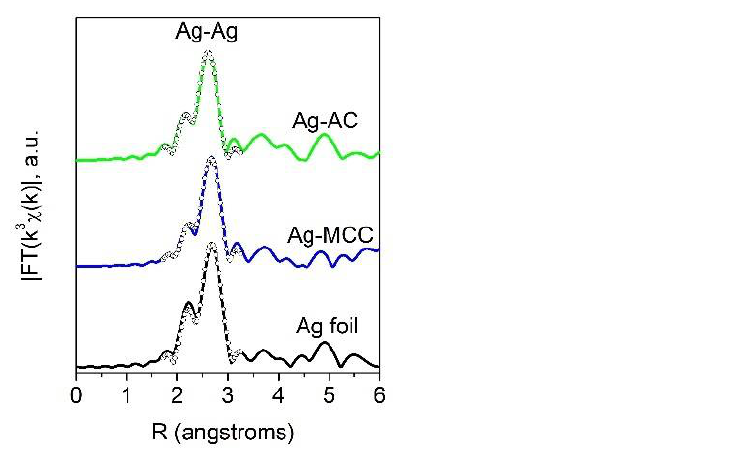
Figure 9. Fourier transforms of Ag K-edge EXAFS spectra for Ag-cellulose composites: experiment (solid lines) and best-fit (open circles). Table 3. Parameters of local environment of silver atoms in Ag-cellulose composites according to EXAFS data.